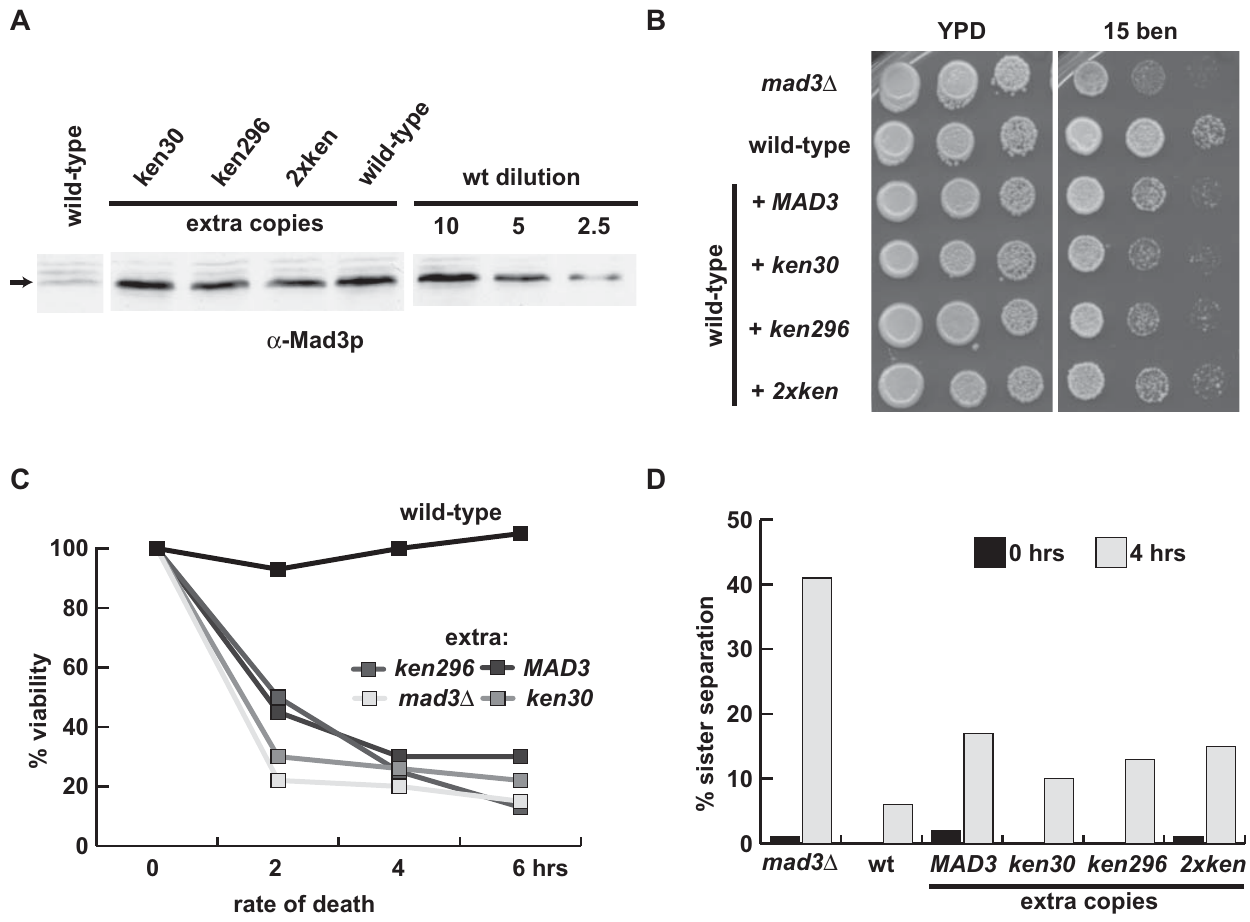
Figure 6. Over-expression of Mad3p induces micro-tubule drug sensitivity, but only subtly perturbs the spindle checkpoint. A) Strains expressing extra integrated copies of wild-type MAD3 or ken mutant mad3 were immunoblotted to quantitate their expression levels. B) Overexpression of Mad3p induces benomyl sensitivity. The over-expression strains were diluted and plated onto rich YPD media with or without the addition of 15 m g/ ml of benomyl. Plates were photographed after 3 days growth at 24 u C. C) Strains overexpressing Mad3p die quickly in the presence of nocodazole. The indicated strains were pre-synchronised in G1 with alpha factor, released into media containing 20 m g/ml nocodazole, and cells were plated out at indicated times. Viability was scored as the percentage of colonies formed relative to the zero time point. D) Mad3p overexpression has a mild effect on sister-chromatid cohesion. The overexpression strains, which containing GFP marked chromosome V, were synchronised in G1 with alpha factor, then released into media containing nocodazole. Sister-chromatid separation was scored as the percentage of cells containing two clearly separated GFP spots.